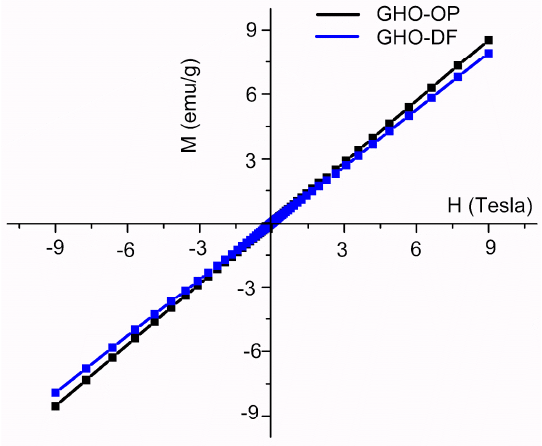
Figure 4. Magnetization curves for OP-GHO, compared with